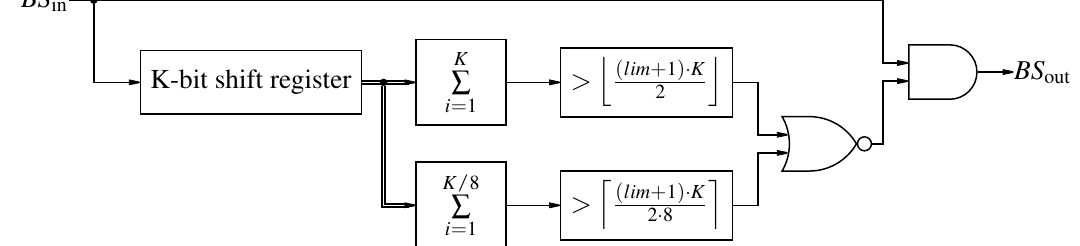
Figure 27. Limiting the upper value of a bit-stream using delay taps for averaging.